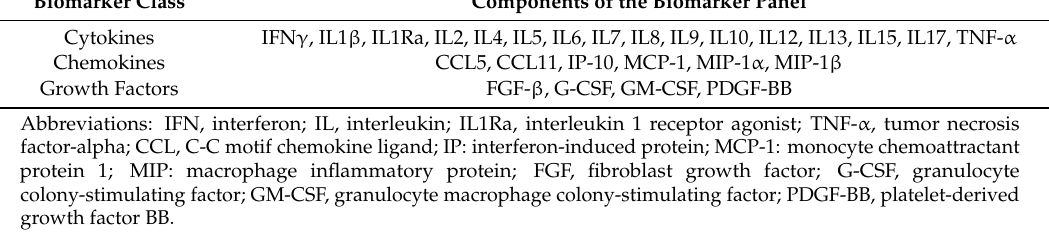
Table 2. Serum inflammatory biomolecules assayed by multiplex immunoassay. Biomarker Class